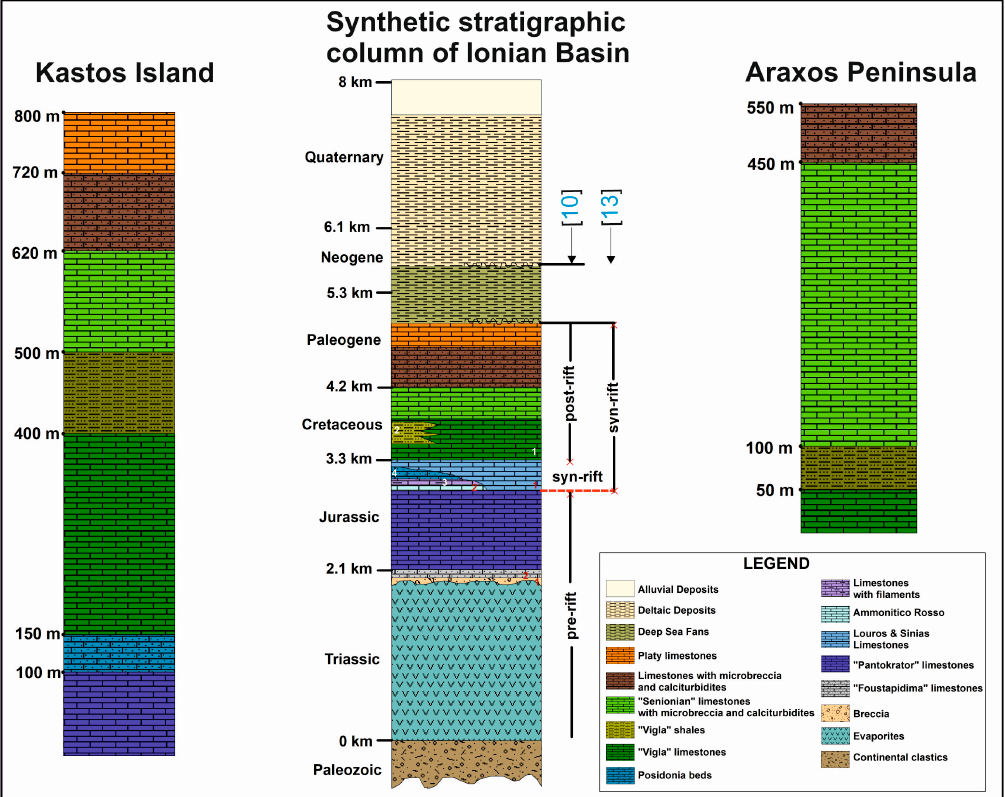
Figure 2. Detailed synthetic lithostratigraphic columns from Kastos Island and Araxos peninsula, in relation to the synthetic stratigraphic column of Ionian zone (modified from [10]).